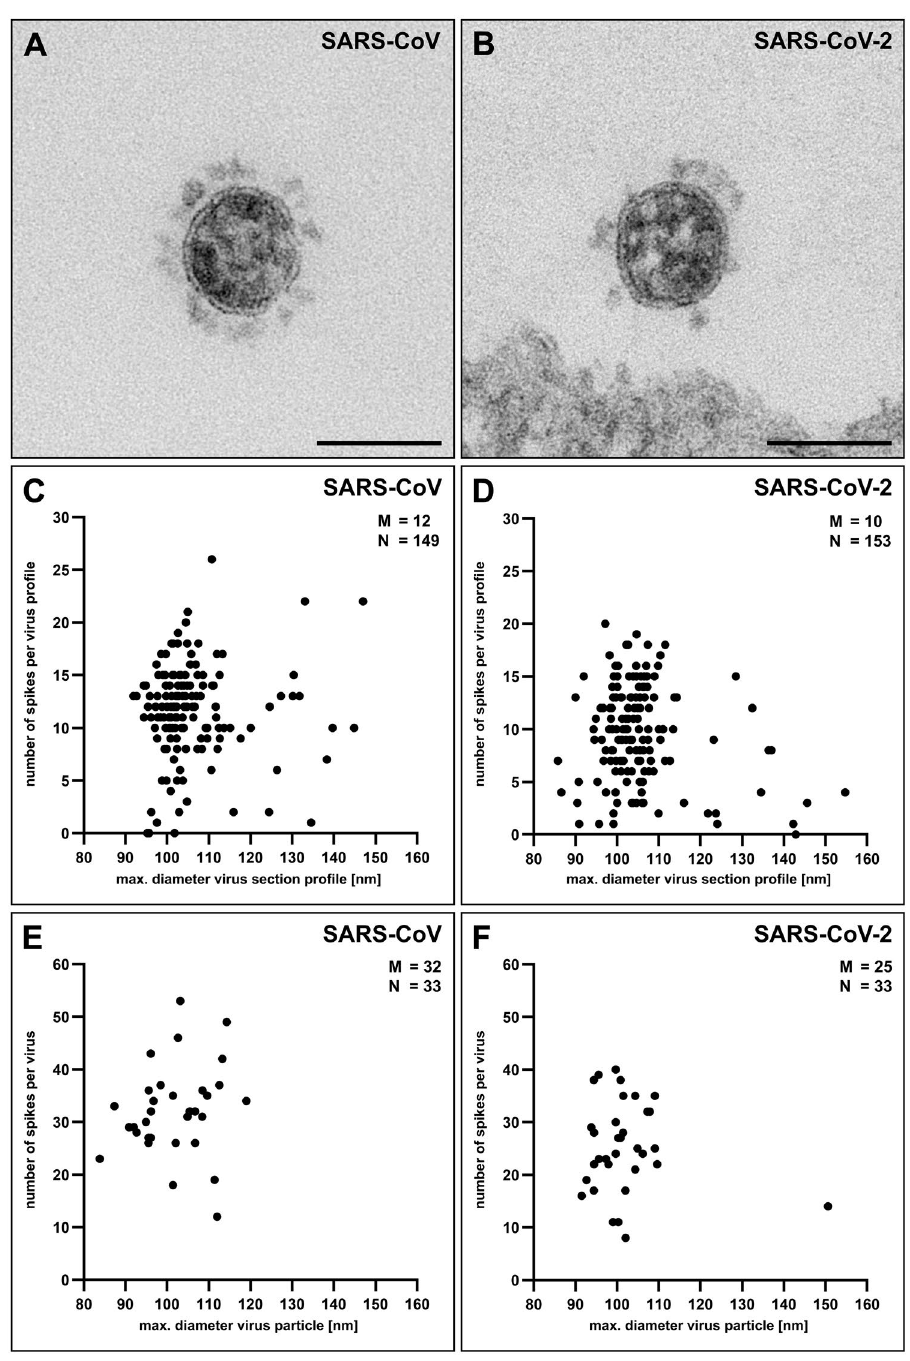
Figure 5. Determination of the spike number of SARS-CoV and SARS-CoV-2 by transmission EM. ( A , B ) Single virus particles of either SARS-CoV ( A ) or SARS-CoV-2 ( B ) in ultrathin (45 nm) sections which show differences in their spike number. Scale bars = 100 nm. ( C , D ) Scatter plot of the number of spikes per maximal particle profile diameter of SARS-CoV ( C ) and SARS-CoV-2 ( D ) (datasets 06 and 07; Table 1) in ultrathin (45 nm) sections. ( E , F ) Scatter plot of the number of spikes per maximal particle diameter of SARS-CoV ( E ) and SARS-CoV-2 ( F ) (datasets 11 and 12; Table 1) in tomograms of thin (200–250 nm) sections. M = median; N = number of measured